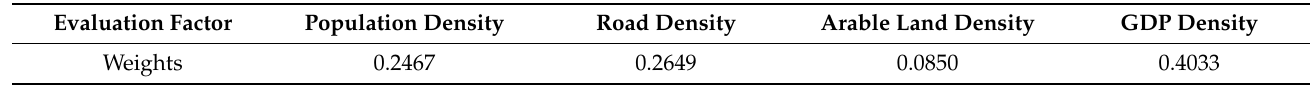
Table 8. Calculation results of objective weights of vulnerability assessment factors.